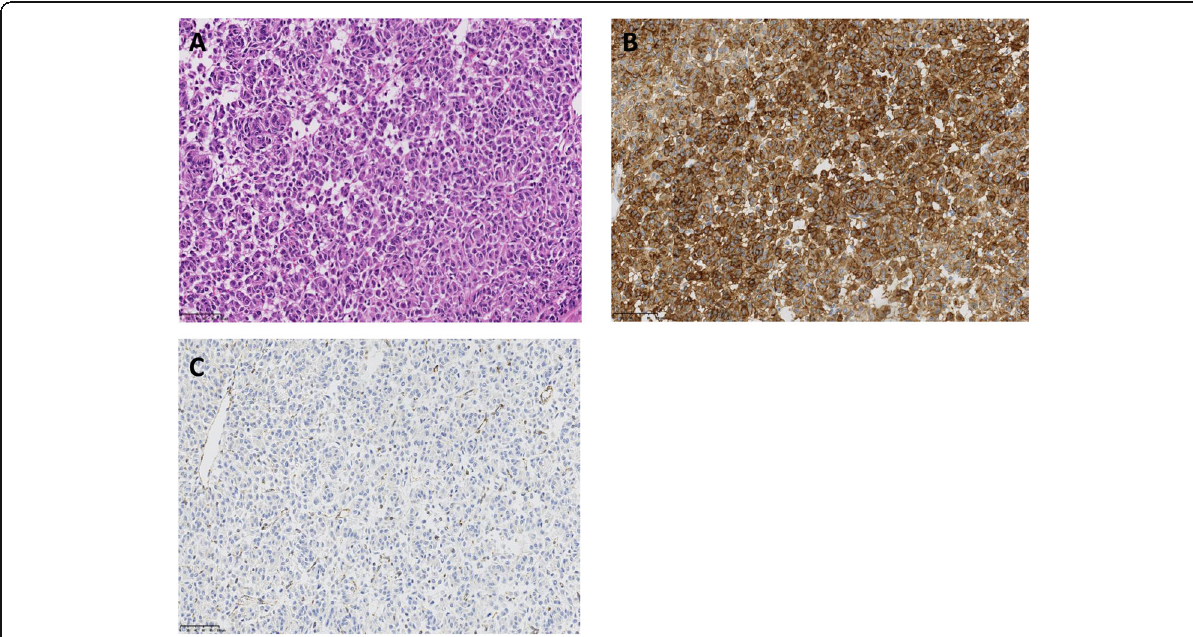
Fig. 8 a Tumor cells showing an epithelioid pattern, with b all eight tumors being diffusely immunoreactive with KIT antibodies. c Tumors were succinate dehydrogenase